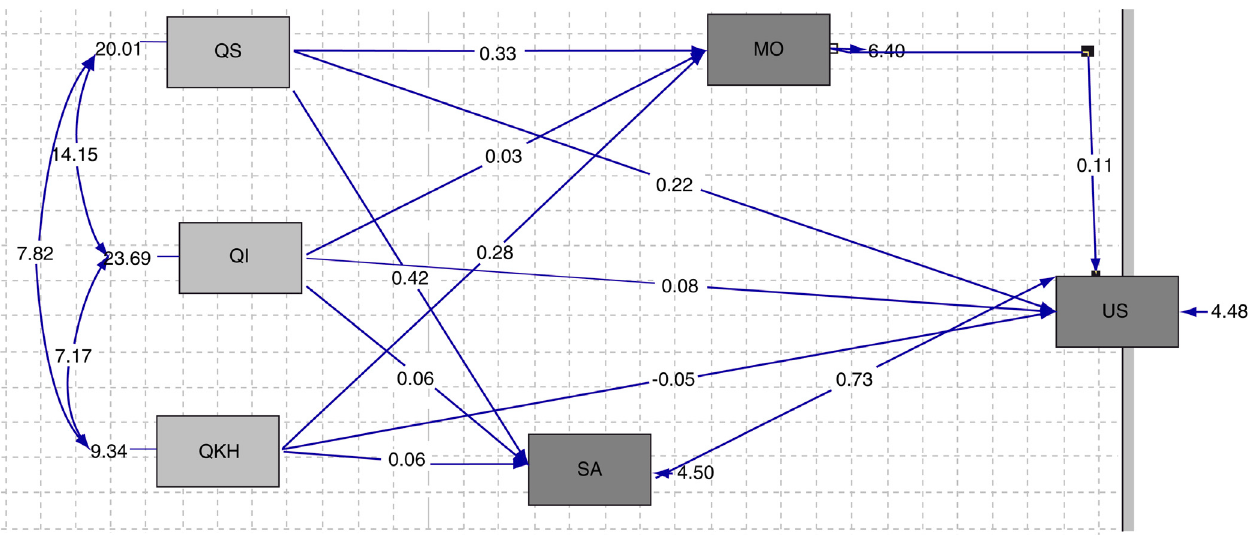
Figure 2. The full empirical path model for the effects of the variables used in the evaluation of the education system. QS: quality of system, QI: Quality of information, QKH: Quality of service, SA: satisfactory, MO: Intention to use, US: usefulness.